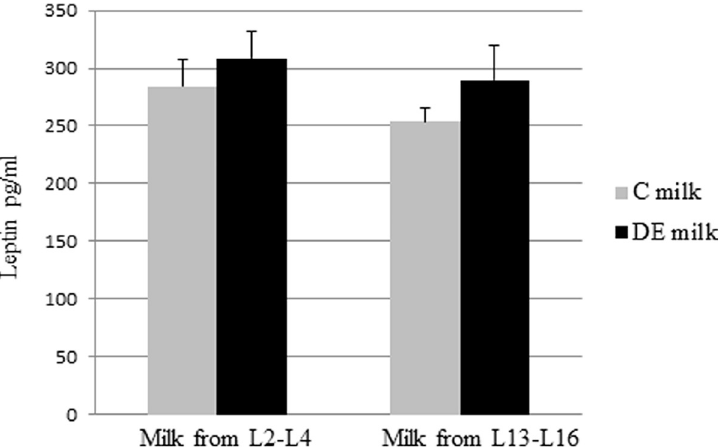
Days 13 to 16 (L13-L16; 9 C and 9 DE rabbits) of lactation. Data are mean ±